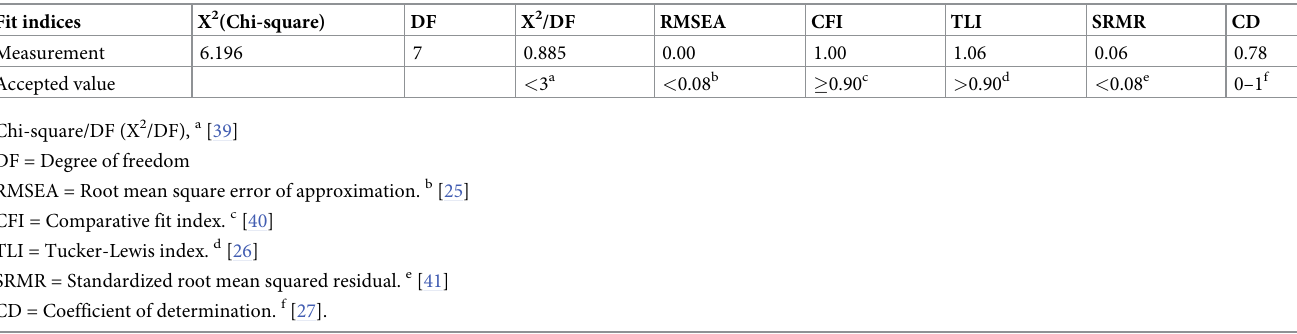
Table 6. Goodness-of-fit indices for the measurement